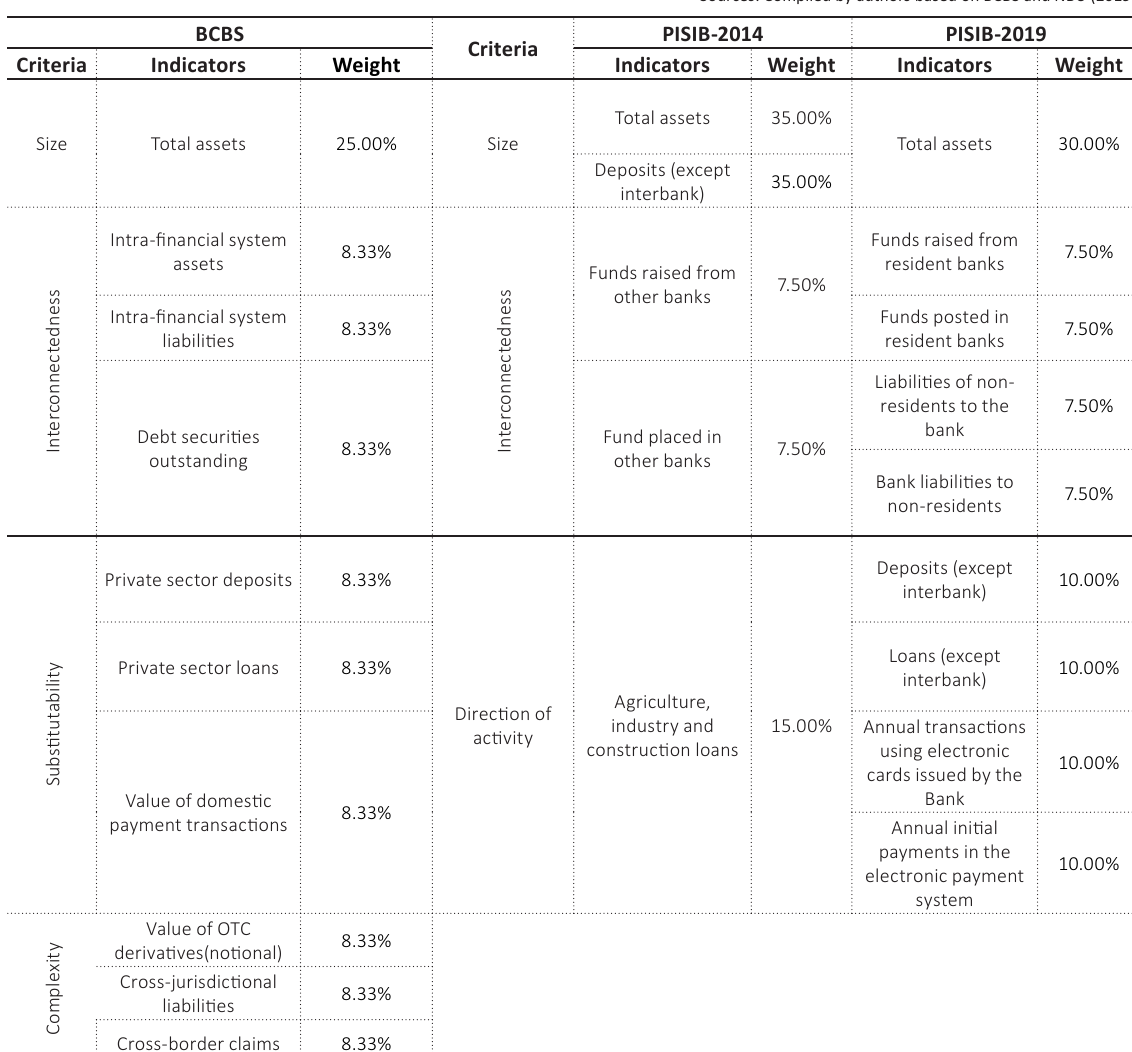
Table 2. Comparison of Basel Committee’s D-SIB and 2014 and 2019 revised versions of the NBU’s assessment